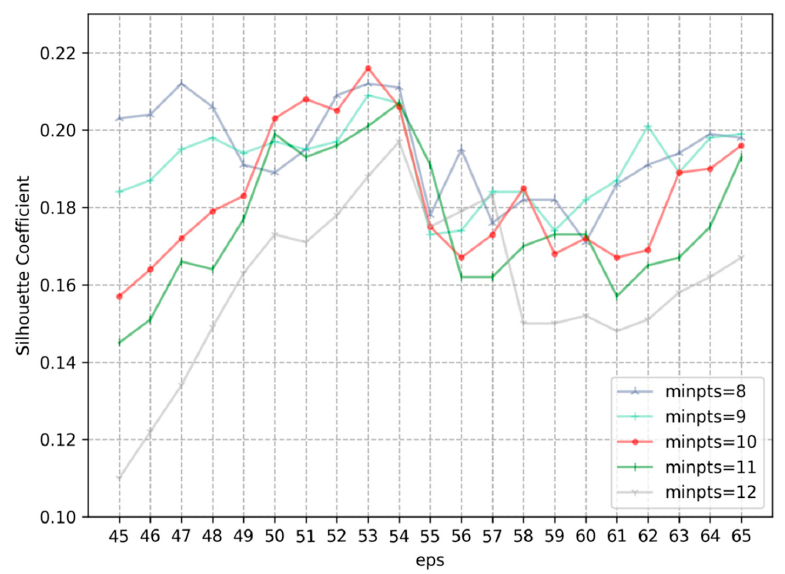
Figure 3. The results of clustering parameter training in the typical sample region.